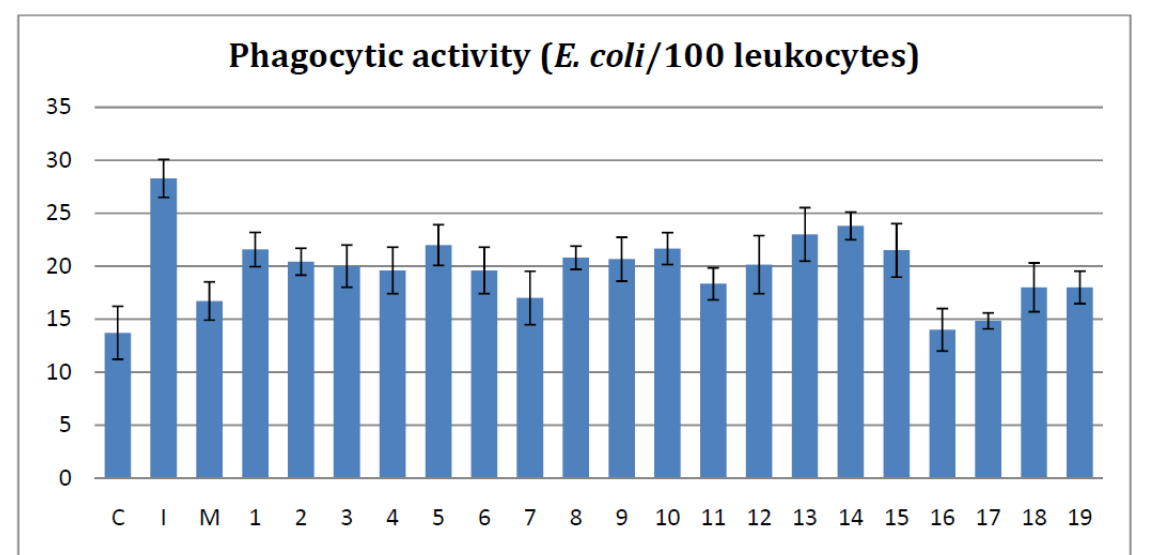
Figure 1. The effects of the tested bisthiazoles on the PA levels.